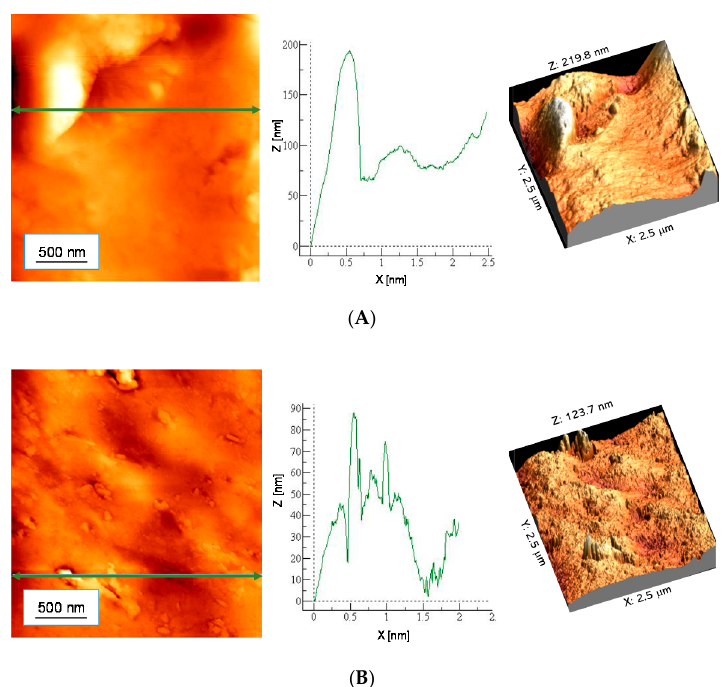
Figure 8. AFM images of Aloe vera -modified hydrogels: ( A ) 10 mL PEGDA 700, ( B ) 12 mL PEGDA 700.